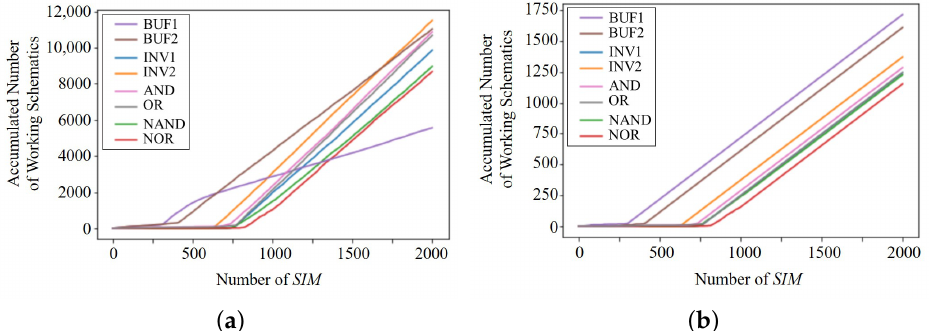
Figure 10. Plots of the number of extracted working schematics for target logic gates. ( a ) Training. ( b ) Evaluation.